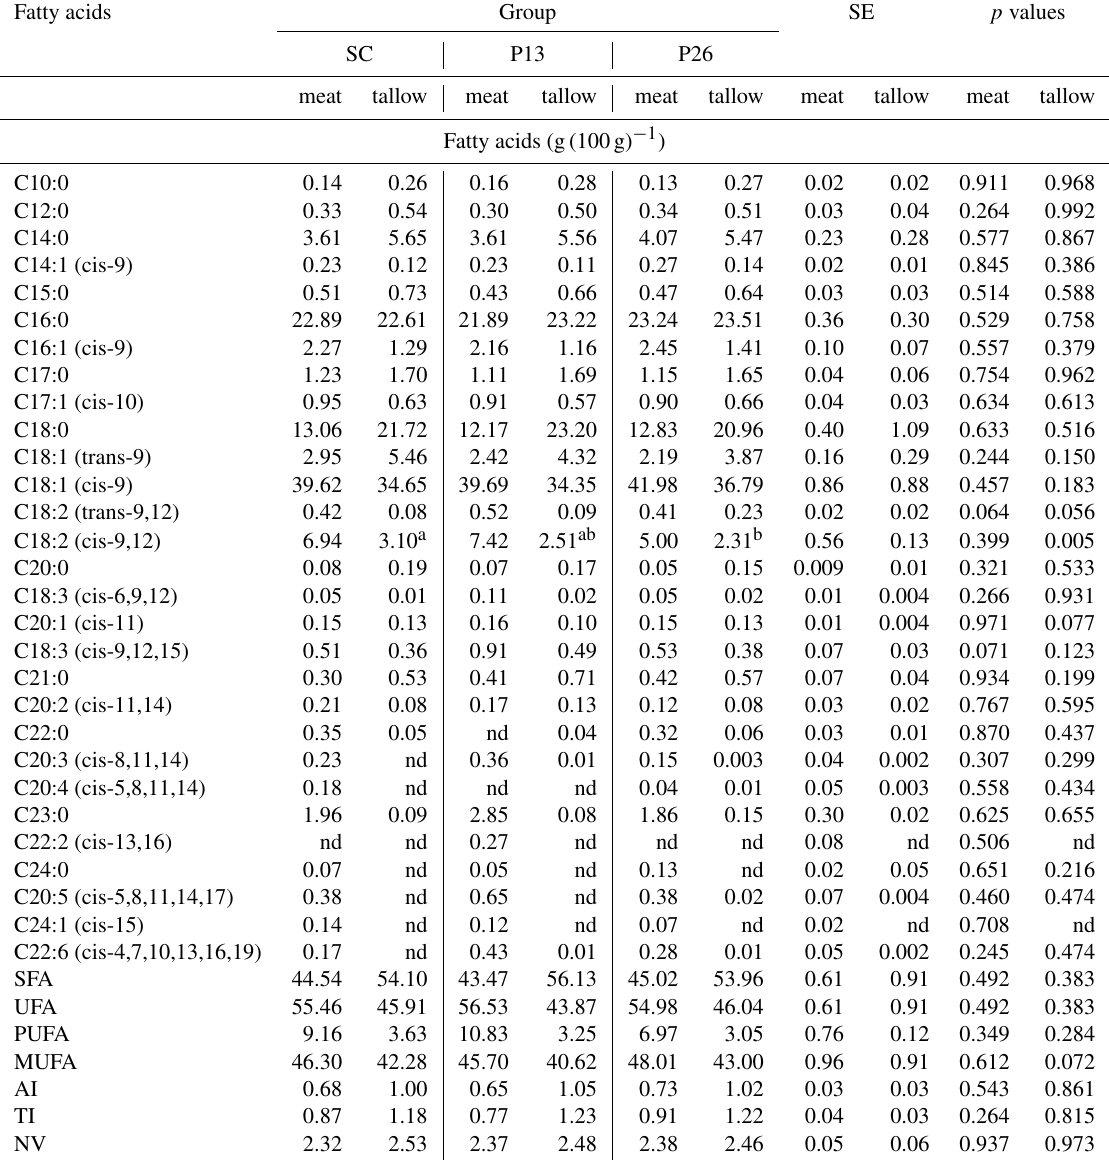
Table 8. Concentration of fatty acids (g(100g) − 1 fatty acids), atherogenic and thrombogenic indices in lambs’ meat and tallow. Fatty acids Group SE p values SC P13 P26 meat tallow meat tallow meat tallow meat tallow meat tallow Fatty acids (g(100g) − 1